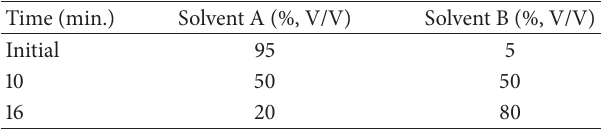
Table 1: The timetable of gradient elution in UPLC conditions. Time